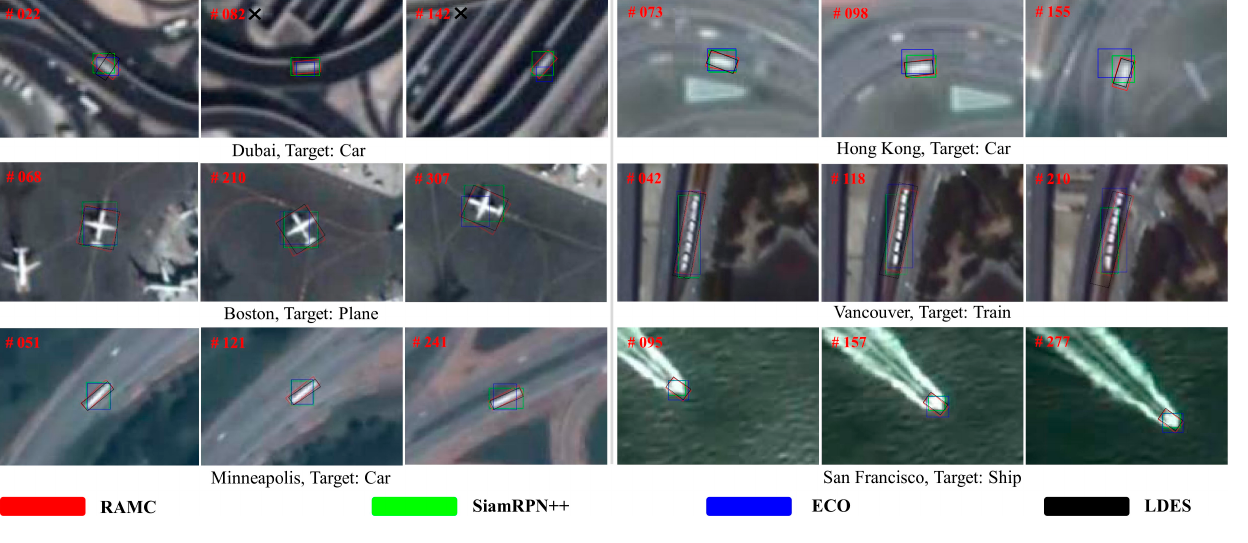
Figure 11. Tracking examples of the top four trackers. The symbol × means tracking failure. The bounding boxes are thinned for better visualization of the tracking effect differences, best viewed by zooming in.